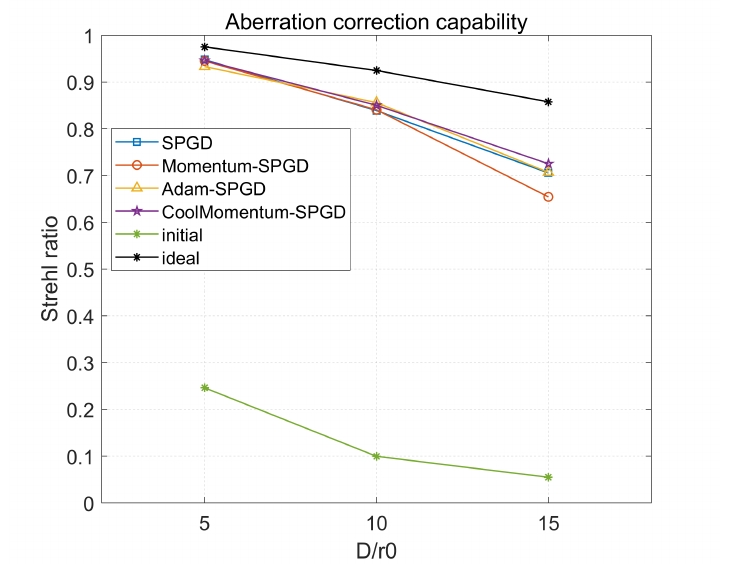
Figure 6. The capability of eliminating wavefront aberration measured in the Strehl ratio. Initial: the initial Strehl ratio of the AO system with uncorrected wavefront. Ideal: the ideal Strehl ratio possibly achieved with a 97-element deformable